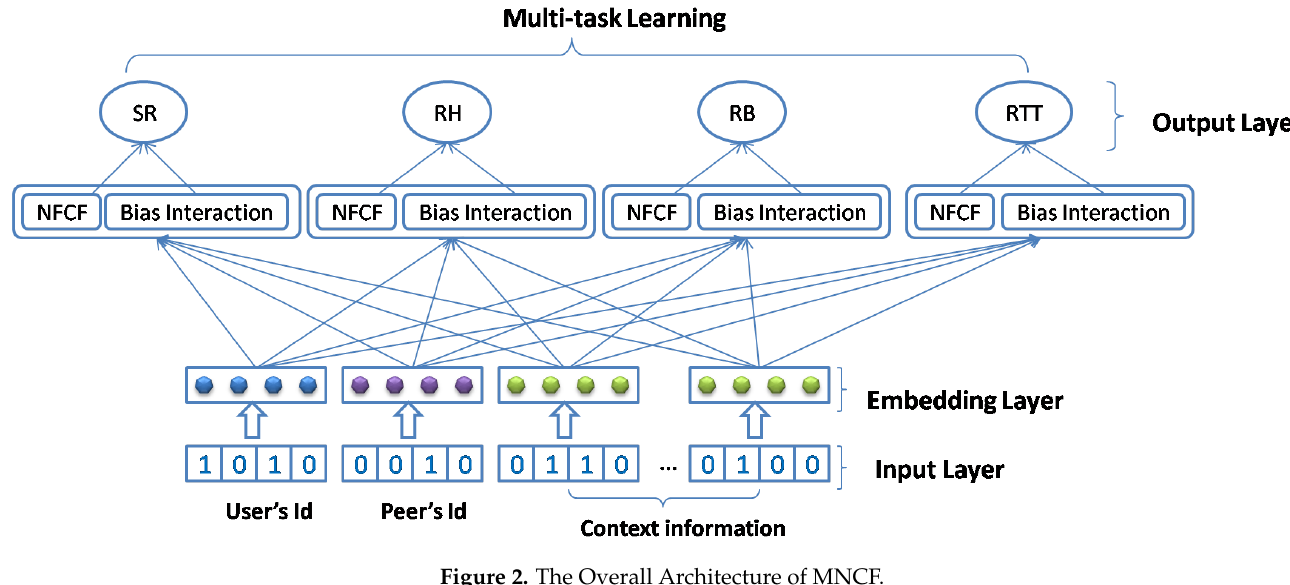
Figure 2. The Overall Architecture of MNCF.